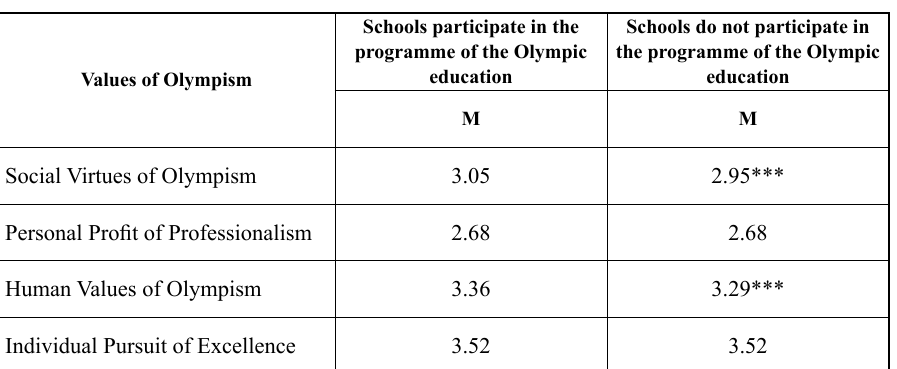
Table 3. The mean score of differently aged pupils’ attitudes towards Olympic values depending on